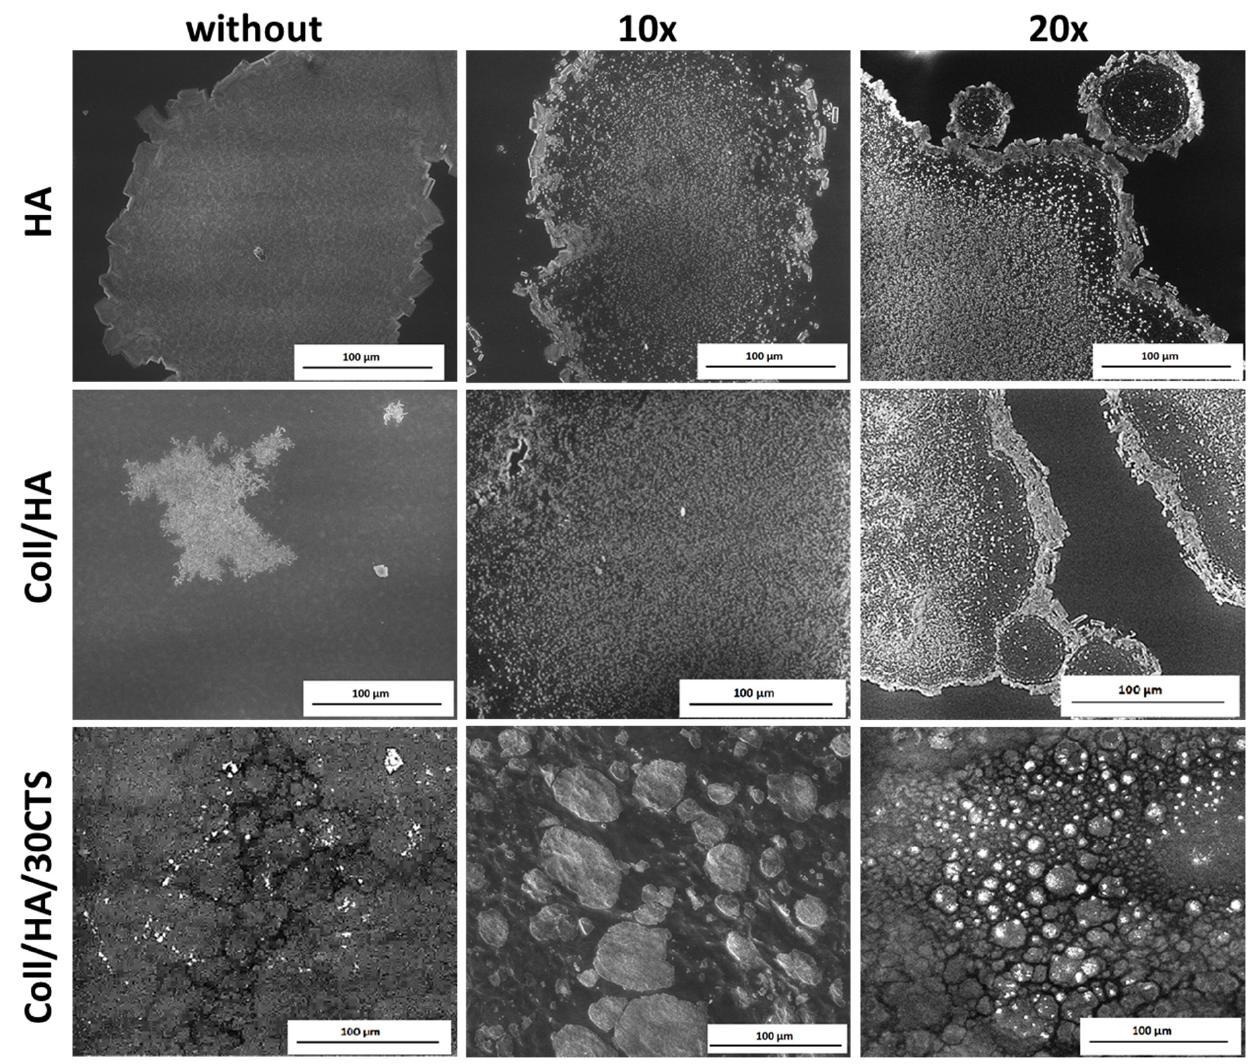
Figure 3. The SEM images of HA, Coll/HA, and Coll//HA/30CTS films before and after treatment of laser radiation (with resolution 100 µm).